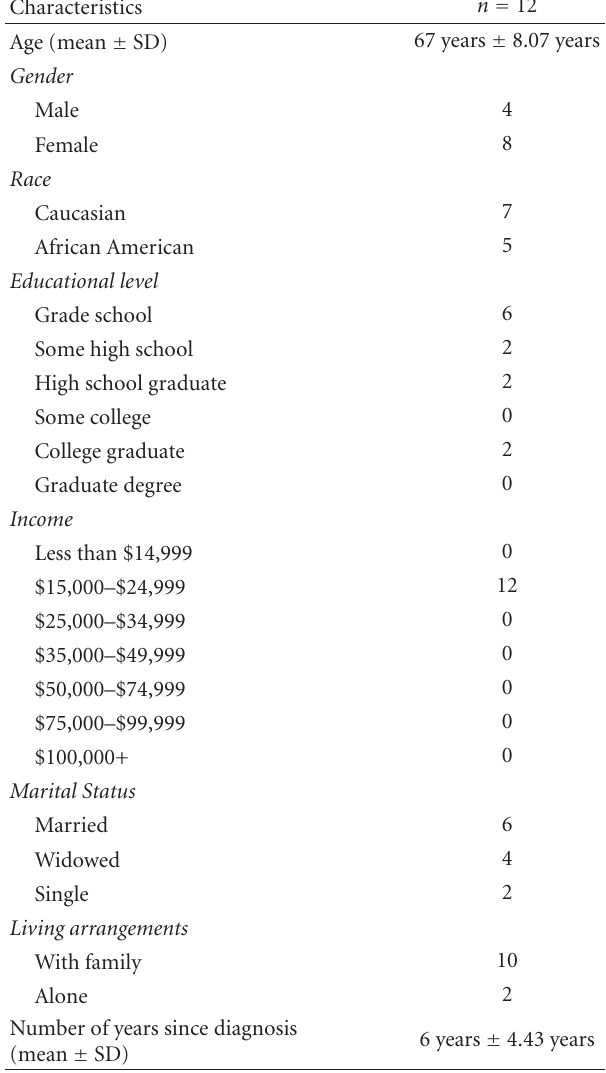
Table 1: Focus group demographic